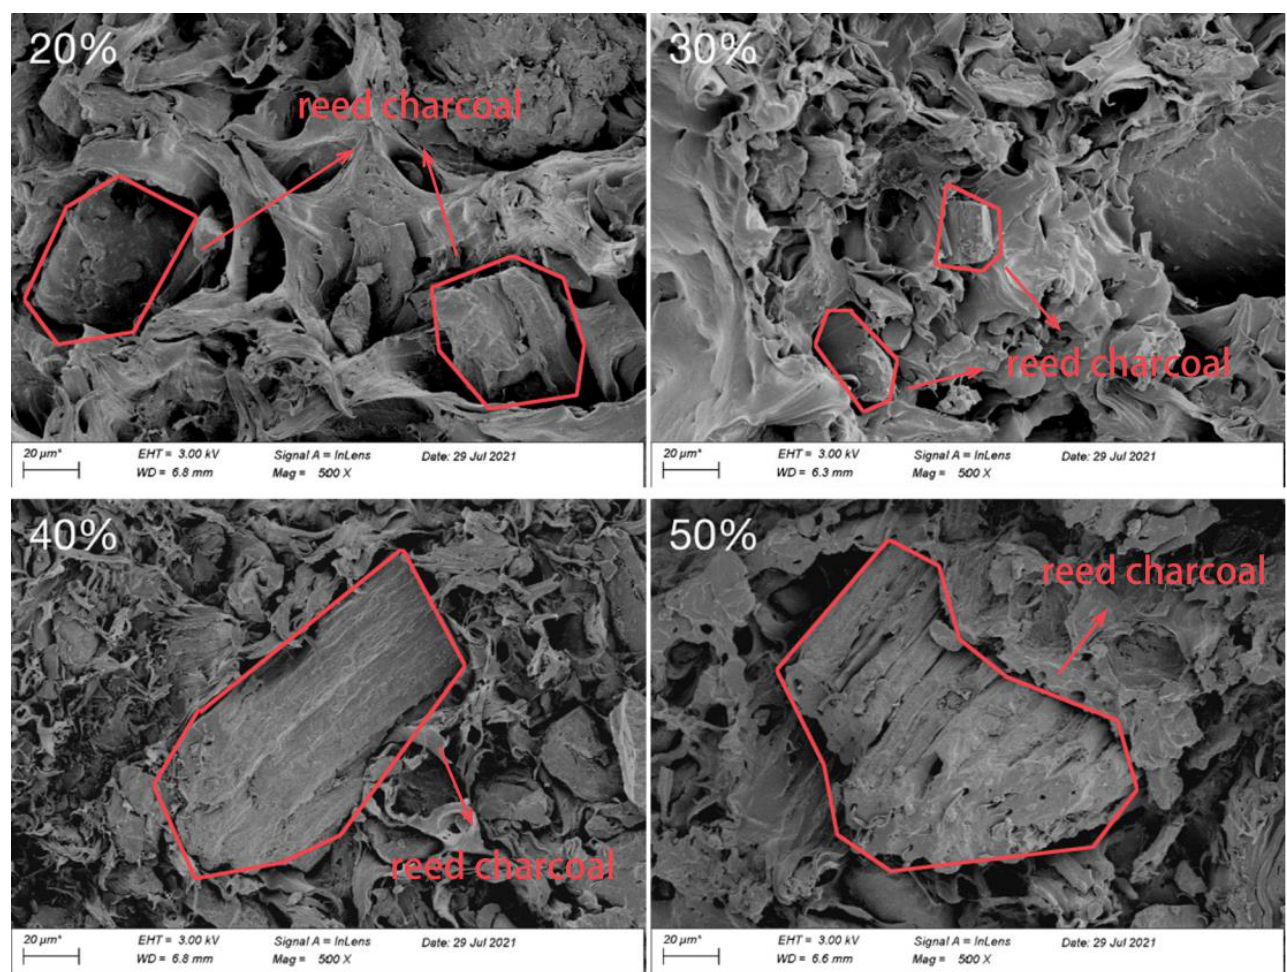
Figure 5. SEM images of tensile fracture surface of RC/PP Composites.